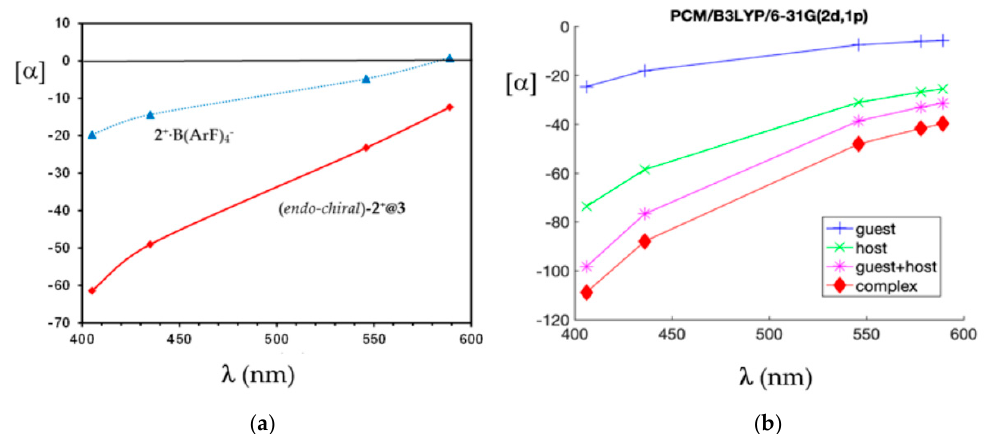
Figure 5. ( a ) Specific optical rotation ([ α ]) of the chiral guest 2 + · [B(Ar F ) 4 ] − salt (blue triangles and dotted blue line) and of the ( endo-chiral )- 2 + @3 pseudorotaxane (red squares and solid red line) at different wavelength. ( b ) Computed ORD curves calculated at the PCM/B3LYP/6-31G(2d,1p) level of theory, for the ( endo-chiral )- 2 + @ 3 complex; isolated guest 2 + (-+-) and host 3 (-x-) blocked in the conformation they have in the complex and the sum of the curves of the isolated guest and host (-*- ).